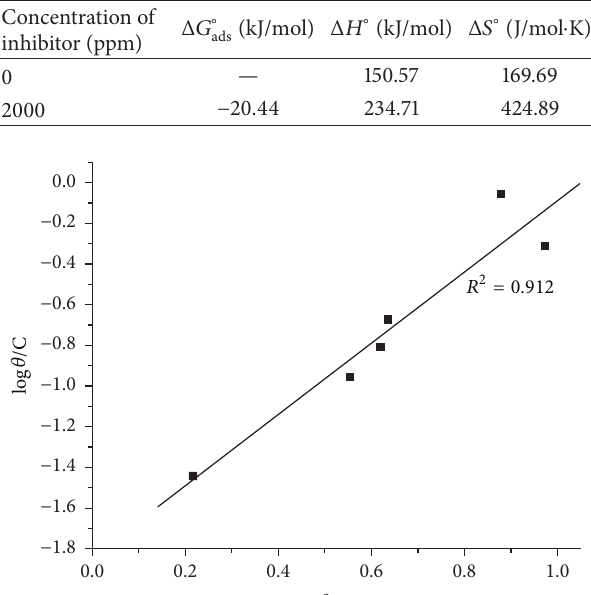
Table 4: Thermodynamic parameters for 304SS in 0.5 M H 2 SO 4 without and with inhibitor.